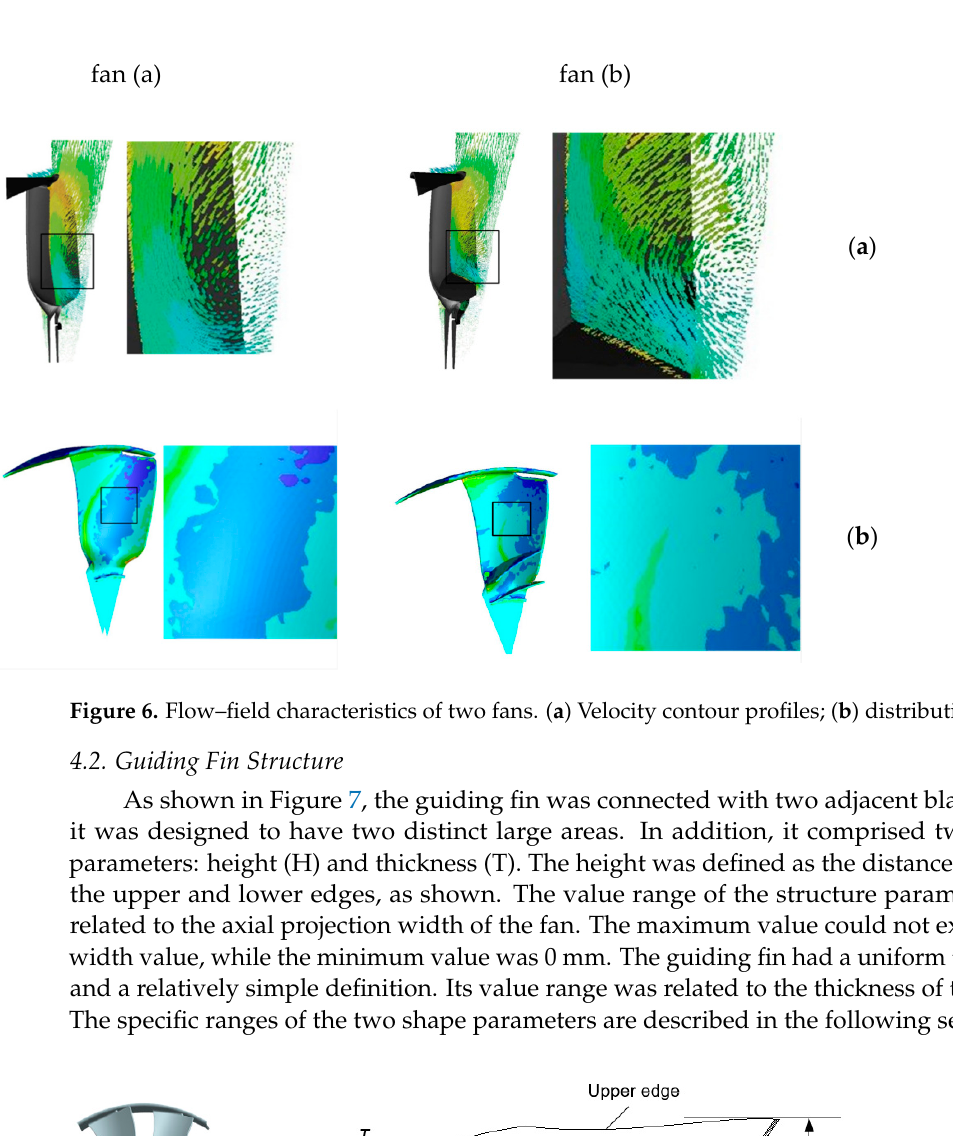
Figure 8. Distribution of CV on fan blade surface with di ff erent guiding fi n heights. 4.4. CV Distribution A ff ected by T The guiding fi n was a kind of thin plate structure, which had a similar shape to that of a fi n, and the T value was 60%~90% of the thickness value of the fan blade. In this paper, it was assumed that the guiding fi n had uniform thickness and no chamfering design. In order to observe the e ff ect of the thickness of the guiding fi n on the pneumatic perfor- mance of the fan, the CV distribution on the blade surface was obtained, as shown in Fig- ure 9. At the same fl ow rate, the CV changed obviously only in the area near the guiding fi n, but it did not change in the other areas of the blade.